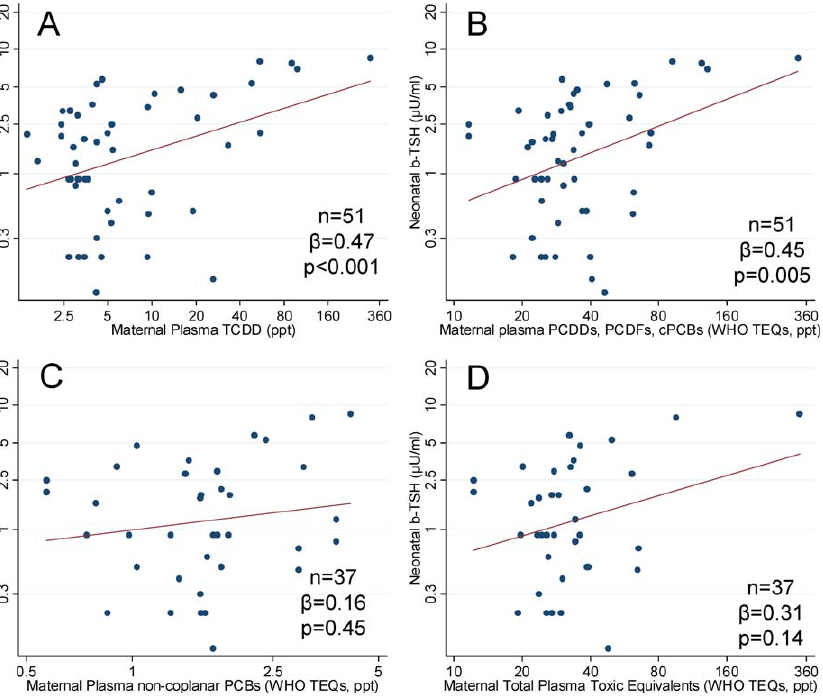
Figure 2. Plasma Dioxin Levels and Neonatal b-TSH Neonatal b-TSH and maternal plasma levels of dioxin-related compounds estimated at the date of delivery for (A) TCDD; (B) PCDDs, PCDFs, coplanar PCB TEQs; (C) non-coplanar PCB TEQs; and (D) total TEQs (i.e., the sum of TEQs from all measured congeners, including PCDDs, PCDFs, coplanar PCBs, and non-coplanar PCBs). Number of mother–child pairs ( n ), standardized regression coefficients ( b ), and p -values ( p ) from models using generalized estimating equations are